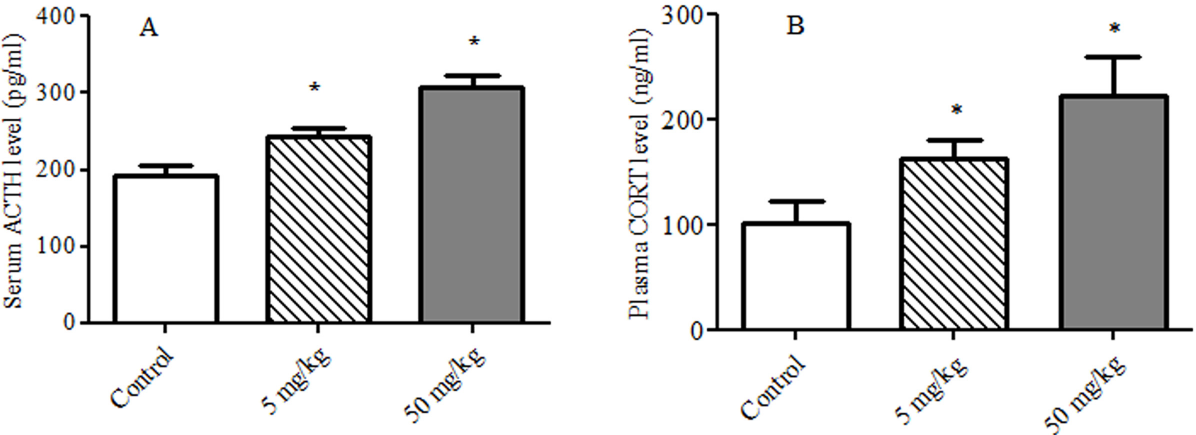
Fig 4. The effects of TDBP-TAZTO (5 and 50 mg/kg) on plasma ACTH (A) and serum CORT (B). The results are presented as mean ± SE (n = 10/group). * p < 0.05, vs. control group.